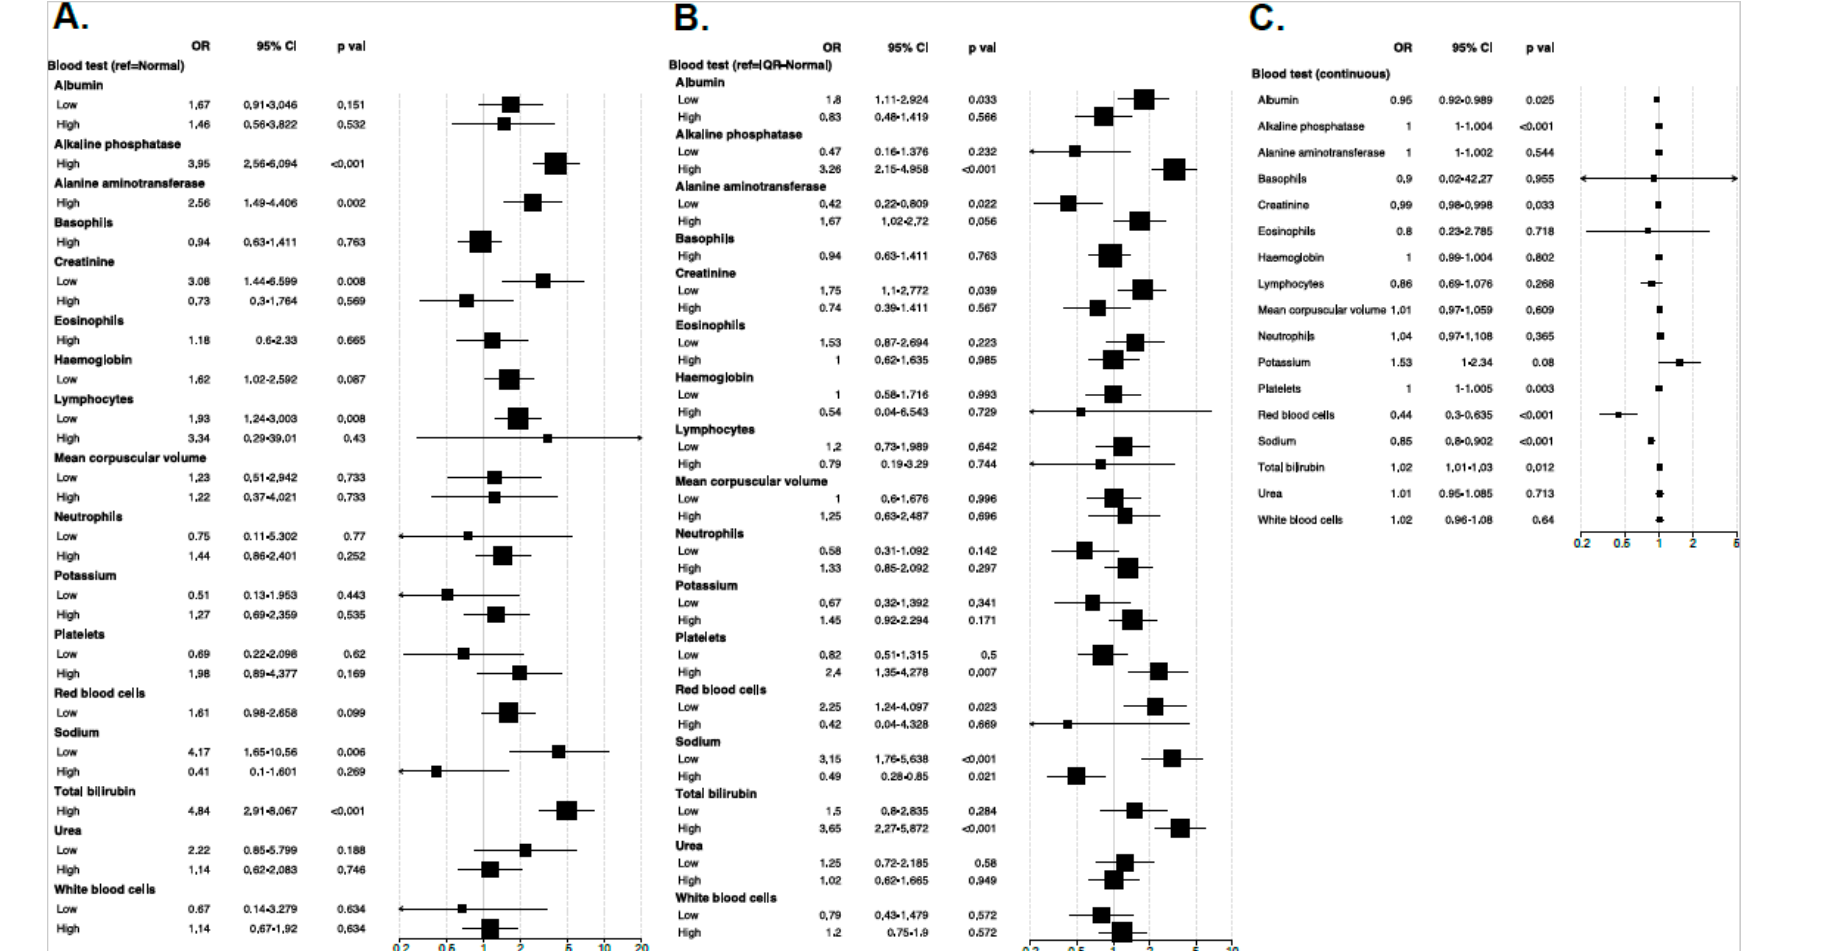
Figure 3. Forest plot showing the association between blood test result variables ( A ): categorical with the known normal range as a reference; ( B ): categorical with interquartile of known normal range as a reference; and ( C ): continuous and odds of PDAC in comparison to non-malignant pancreatic disease group. The odds ratio (OR) and 95% confidence interval (CI) are derived from the logistic regression model controlled for gender, ethnicity and age group. The reported p values are corrected for multiple testing via Benjamini–Hochberg method.